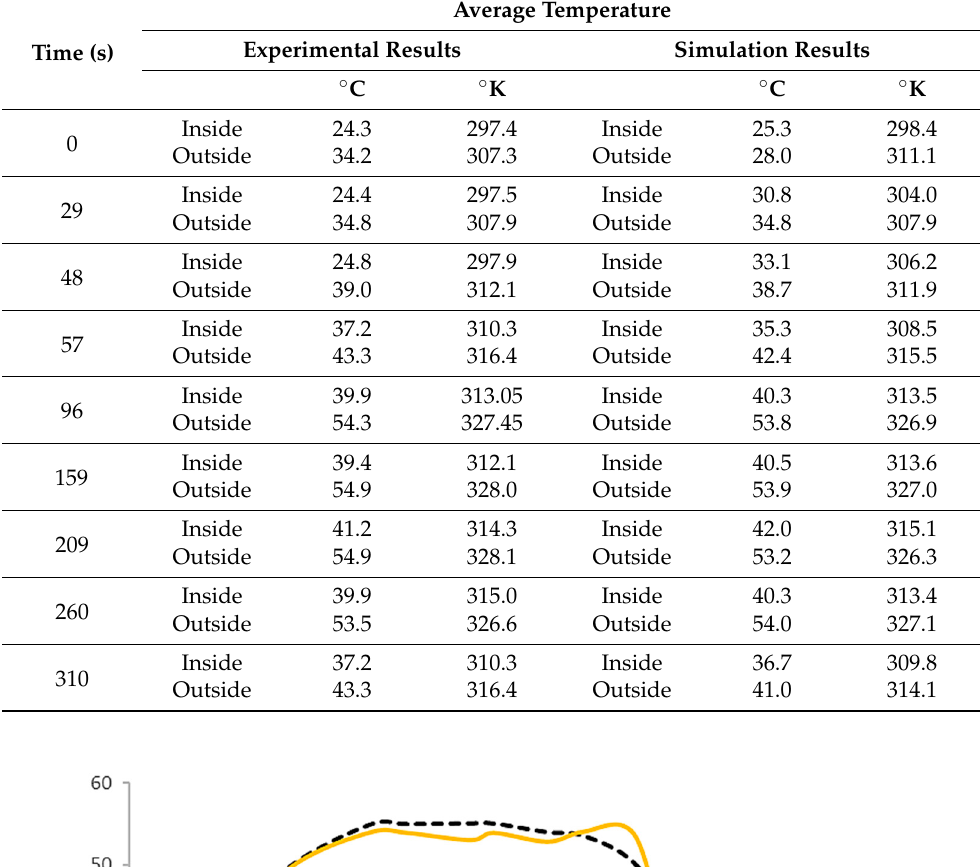
Table 4. Comparison of experiment and simulation results during heat treatment.